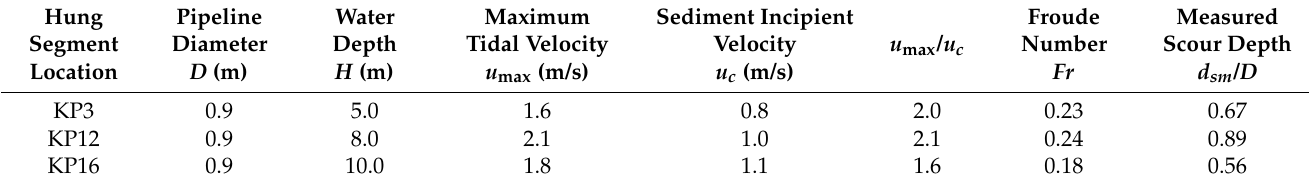
Table 2. Flow conditions and measured scour depth of the Cezhen pipeline.